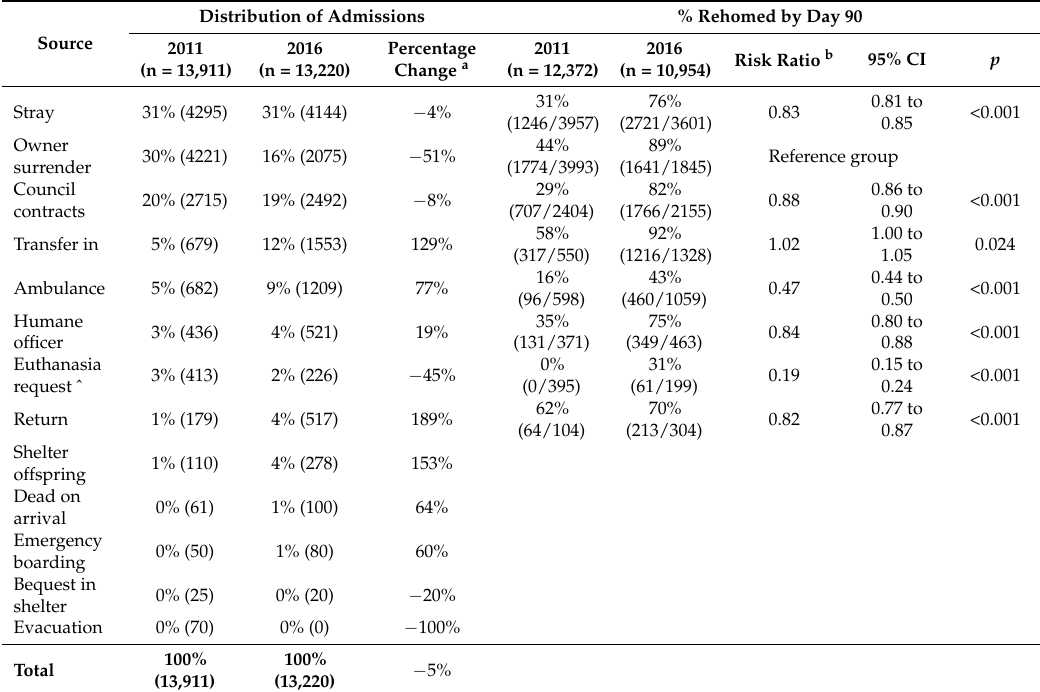
Table 1. Sources of cat admissions into RSPCA Queensland shelters for the years of 2011 and 2016 and numbers and percentages rehomed by day 90 and associated risk